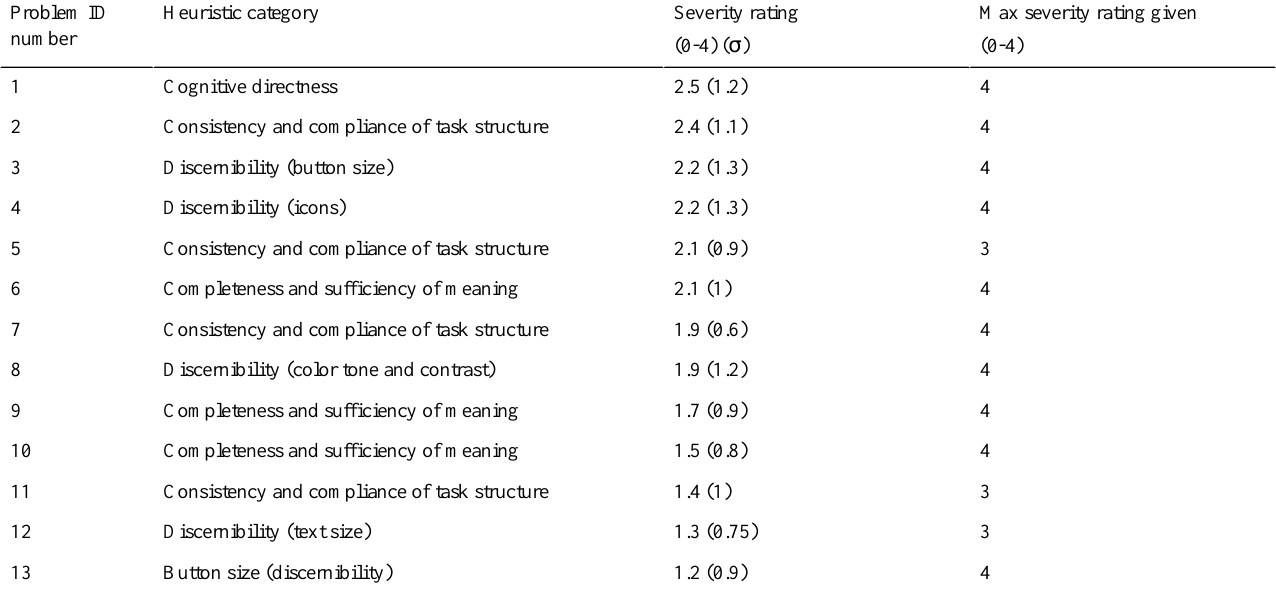
Table 6. Problems uncovered by experts and rated based on mean Likert scores.